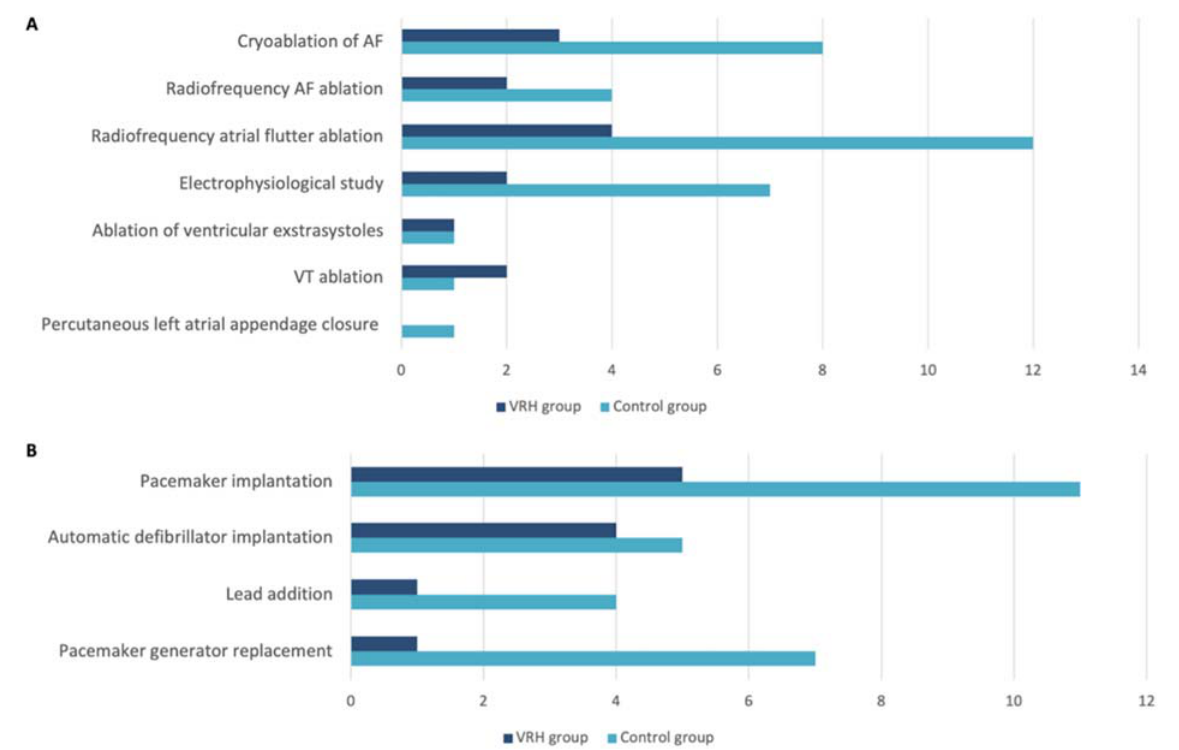
Figure 2. Specific electrophysiological procedure ( A ) and cardiac pacing procedure ( B ). AF: atrial fibrillation; VT: ventricular tachycardia; VRH: virtual reality hypnosis. In patients undergoing VRH, the mean pain values measured with the VAS immediately after the procedure and at discharge were 3.7 ( ± 2.2) and 2.1 ( ± 2.9), respectively; the mean comfort values were 7.8 (1.8) and 7.9 (2.1), respectively. In the control group, the mean VAS pain values were 3.1 (±2.9) and 2.6 (±2.9) immediately after the procedure and at discharge, respectively; the mean comfort values were 9.5 (1.1) and 9.7 (0.7), respec ‐ tively.